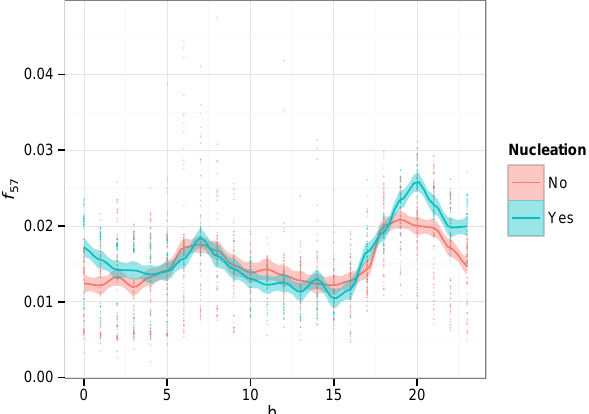
Figure 6. SSE versus the number of clusters. The sharp decrease in SSE stops at five clusters forming an elbow.